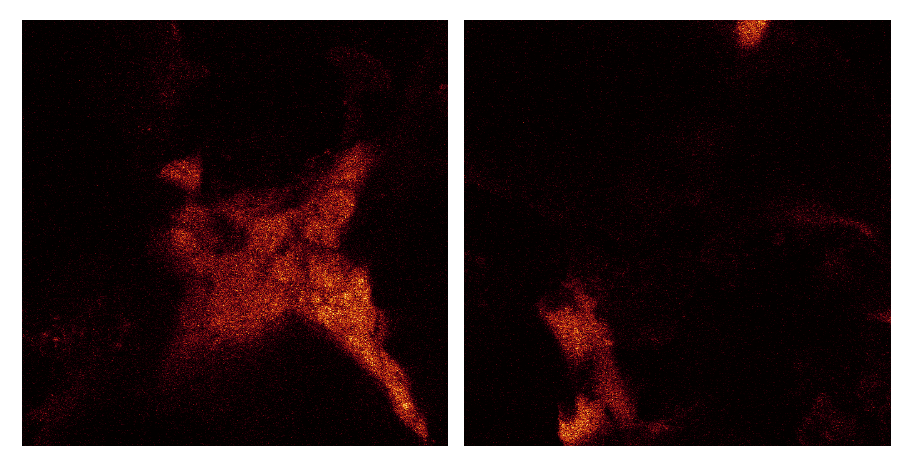
Figure 17. Confocal microscopy image of cells on SBF coating on porous alumina Sample A. There is very little cell coverage even after 24 day cell culture. Results confirm SEM